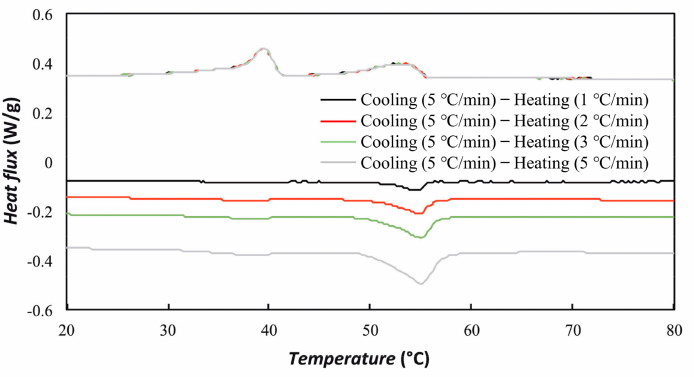
Figure 6. DSC curves of 5 wt% RT55 nano-emulsions with GO as nucleating agent (Reproduced with permission from Ref. [87]. Copyright 2021